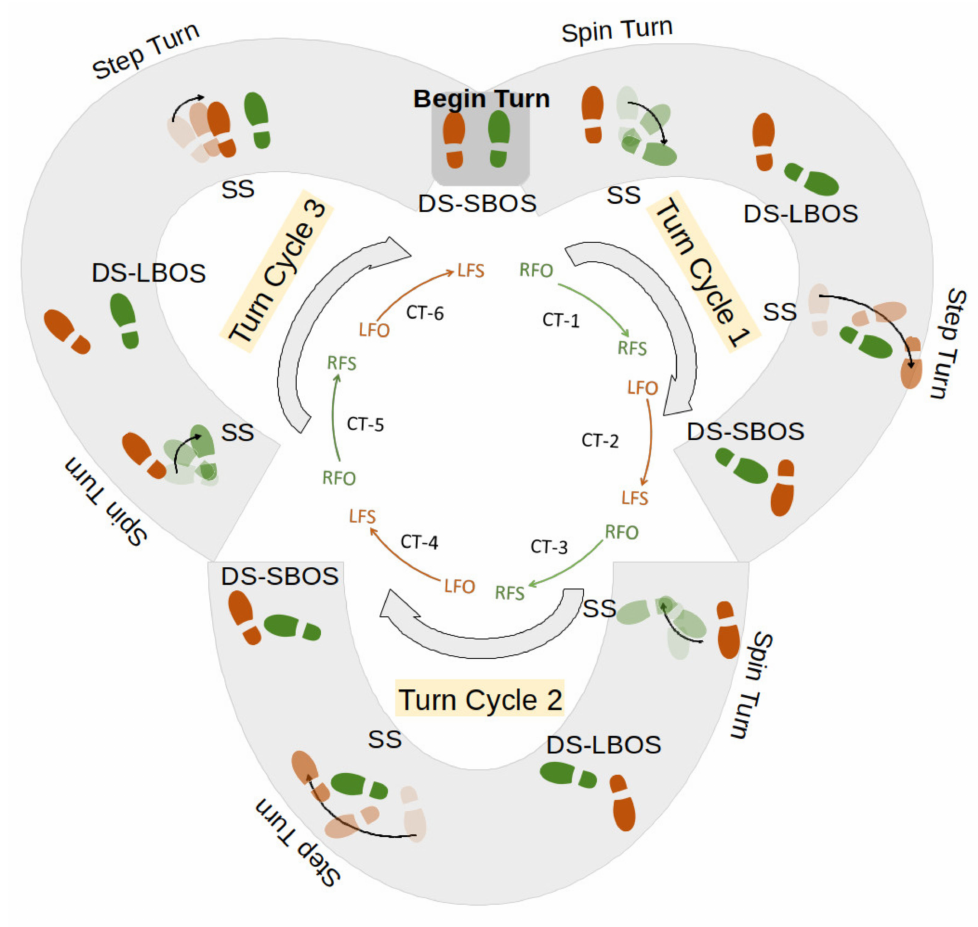
Figure 2. Three turn cycles (TCs) during a 360 ◦